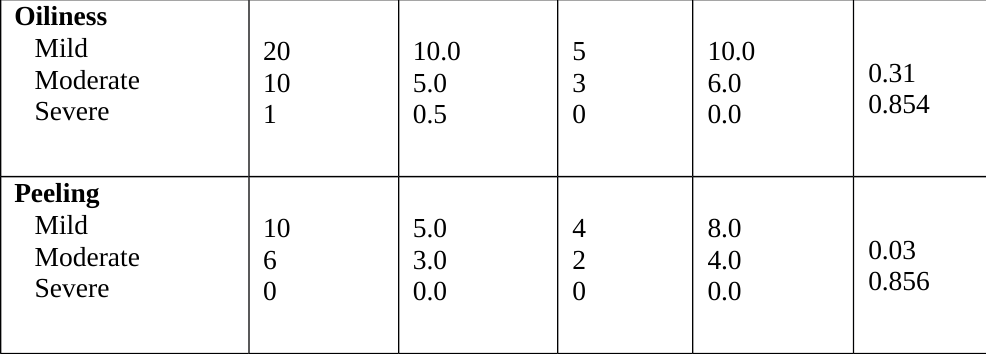
Table (9): Relation between GAAS in group I at end of follow up and sun exposure.